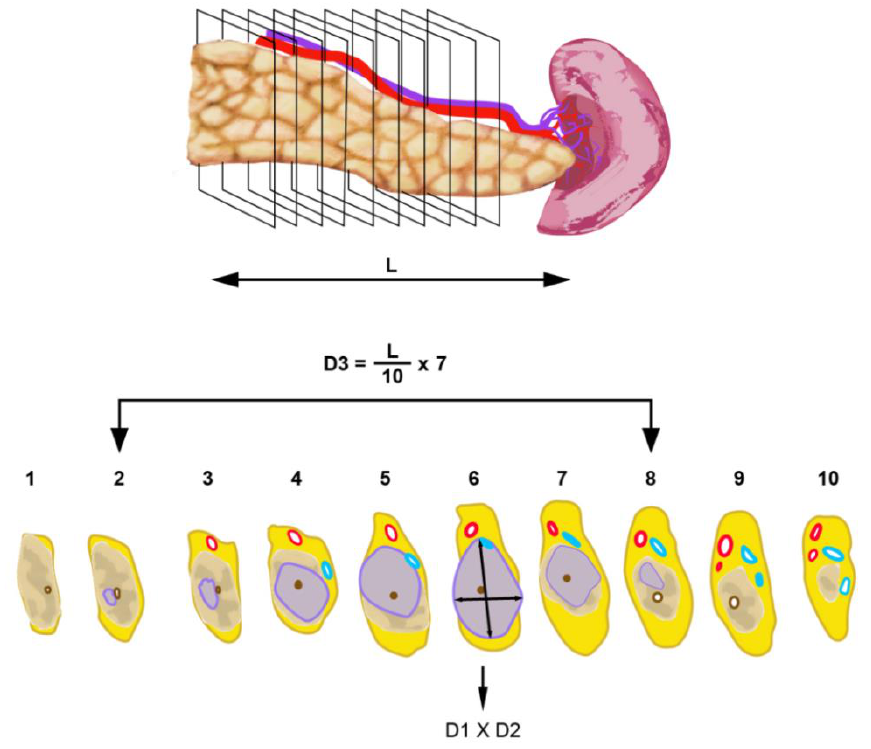
Figure 2. Tumour size measurement in distal pancreatectomy specimens. Following specimen slicing in the sagittal plane, the maximum tumour dimensions (D1 and D3) are measured in a similar fashion as described in Figure 1.